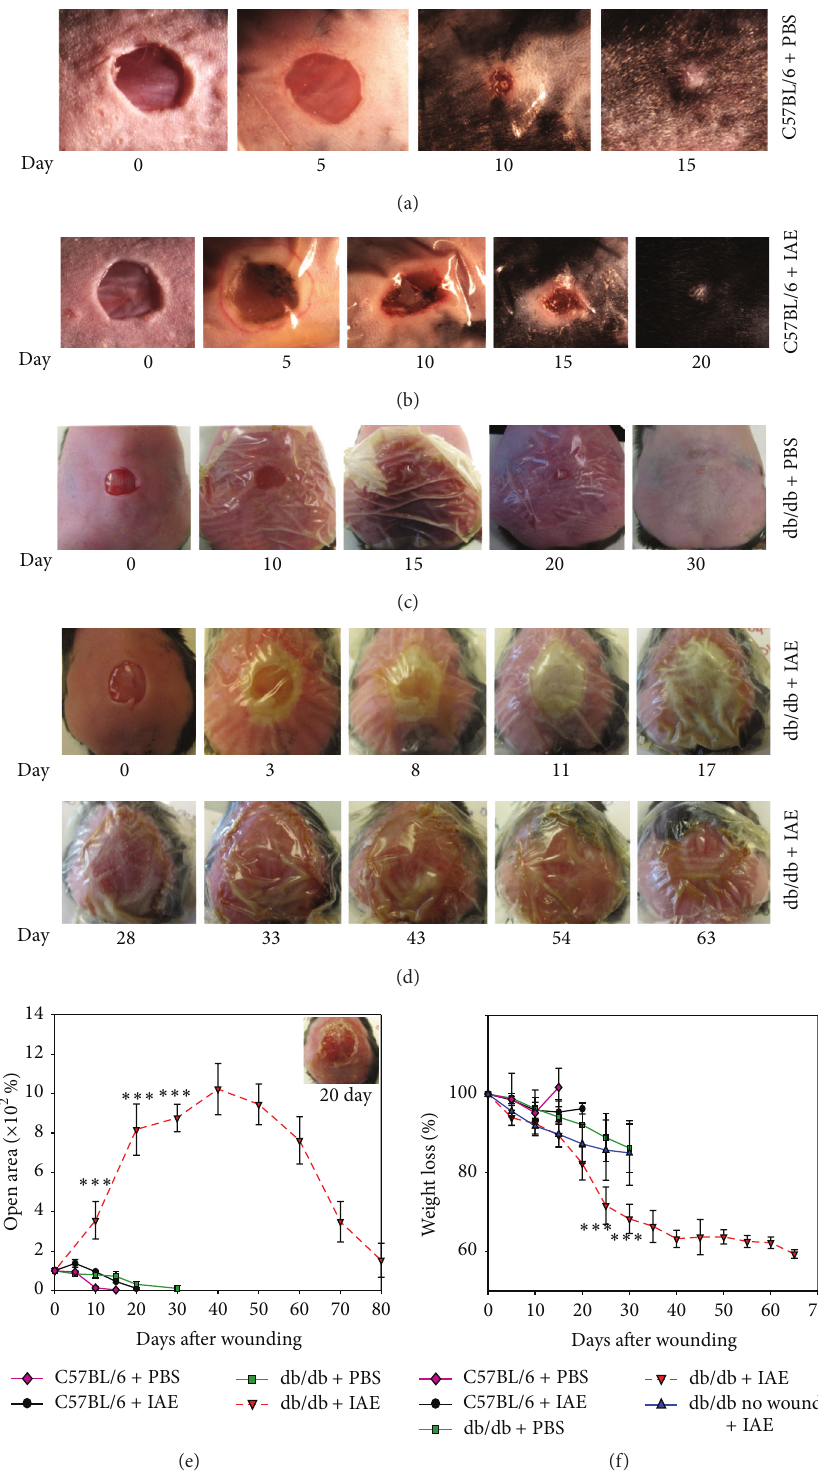
Figure 2: Redox imbalance leads to chronic wound development. (a) Wound closure in C57BL/6 mice treated with PBS occurs by 15 days after wounding. (b) C57BL/6 mice treated with inhibitors heal by 20 days after wounding. (c) Db/db mice treated with PBS heal completely by 30 days. (d) Db/db mice treated with inhibitors become chronic and do not heal for as long as 100 days. (e) Percent open wound area over time in wounds of C57BL/6 and db/db mice after treatment with PBS or IAE. (f) Weight loss in C57BL/6 and db/db mice after PBS and IAE treatment. 𝑛 = 7 for each treatment except for db/db mice treated with IAE; we have now treated well over 100 mice. All data are mean ± SD. ∗ 𝑃 < 0.05 , ∗∗ 𝑃 < 0.01 , ∗∗∗ 𝑃 < 0.001